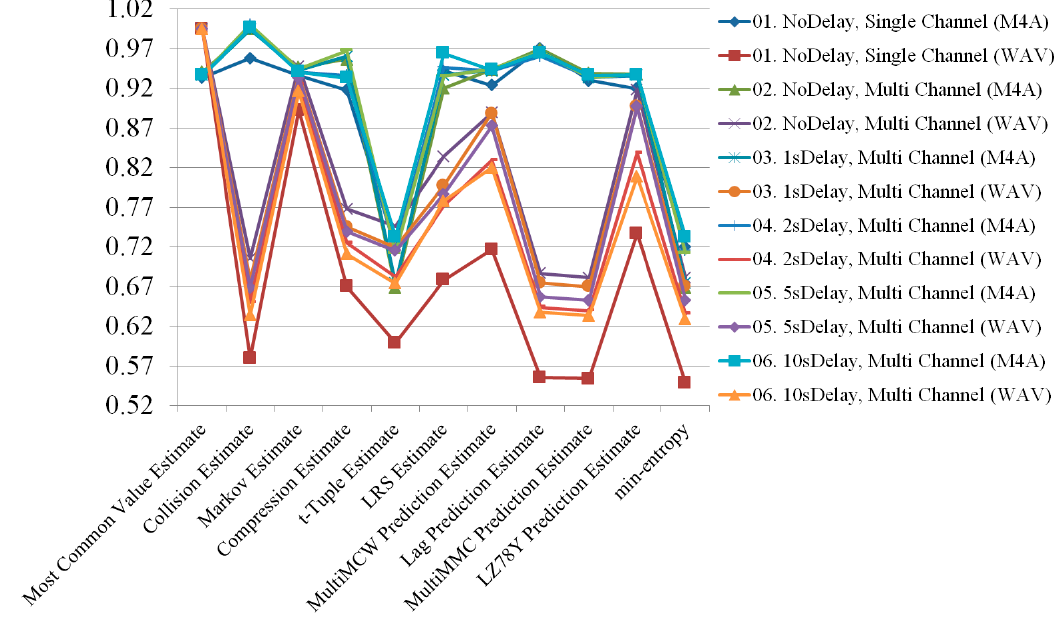
Figure 12. Randomness comparison results of radio signals collected under all conditions.